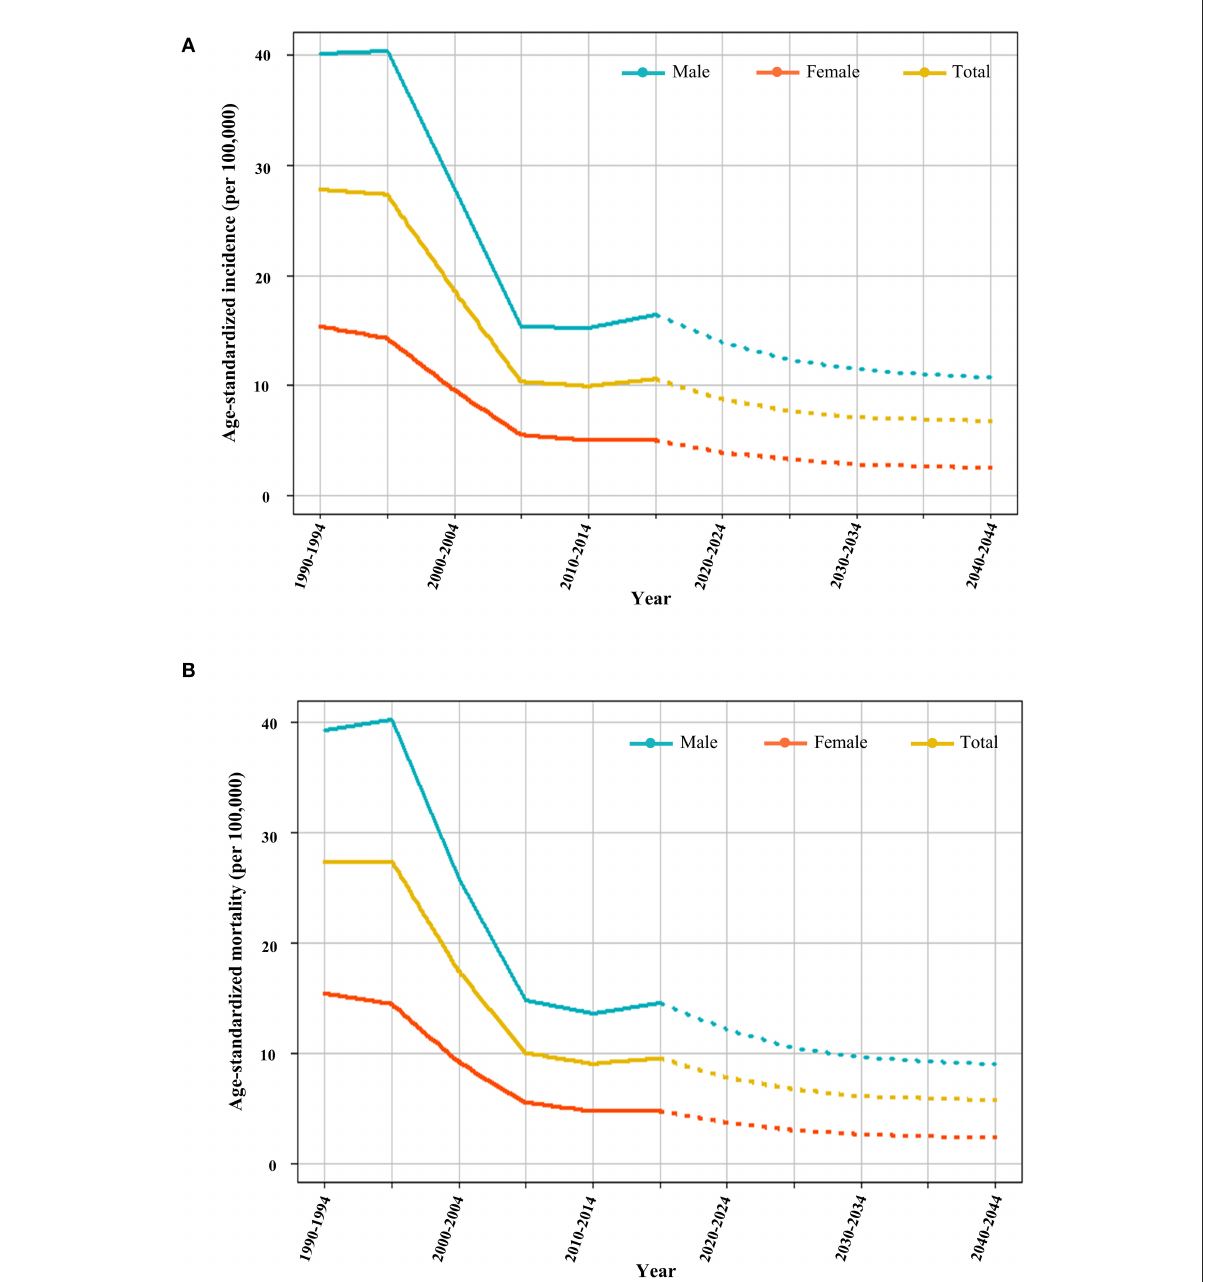
FIGURE4 Prediction of incidence and mortality of liver cancer. (A) Plots of age-standardized incidence of liver cancer from 1990 to 2044. The solid lines indicate the observed values (1990 to 2019) and the dotted lines are the predicted values (2020 to 2044). (B) Plots of LC age-standardized mortality from 1990 to